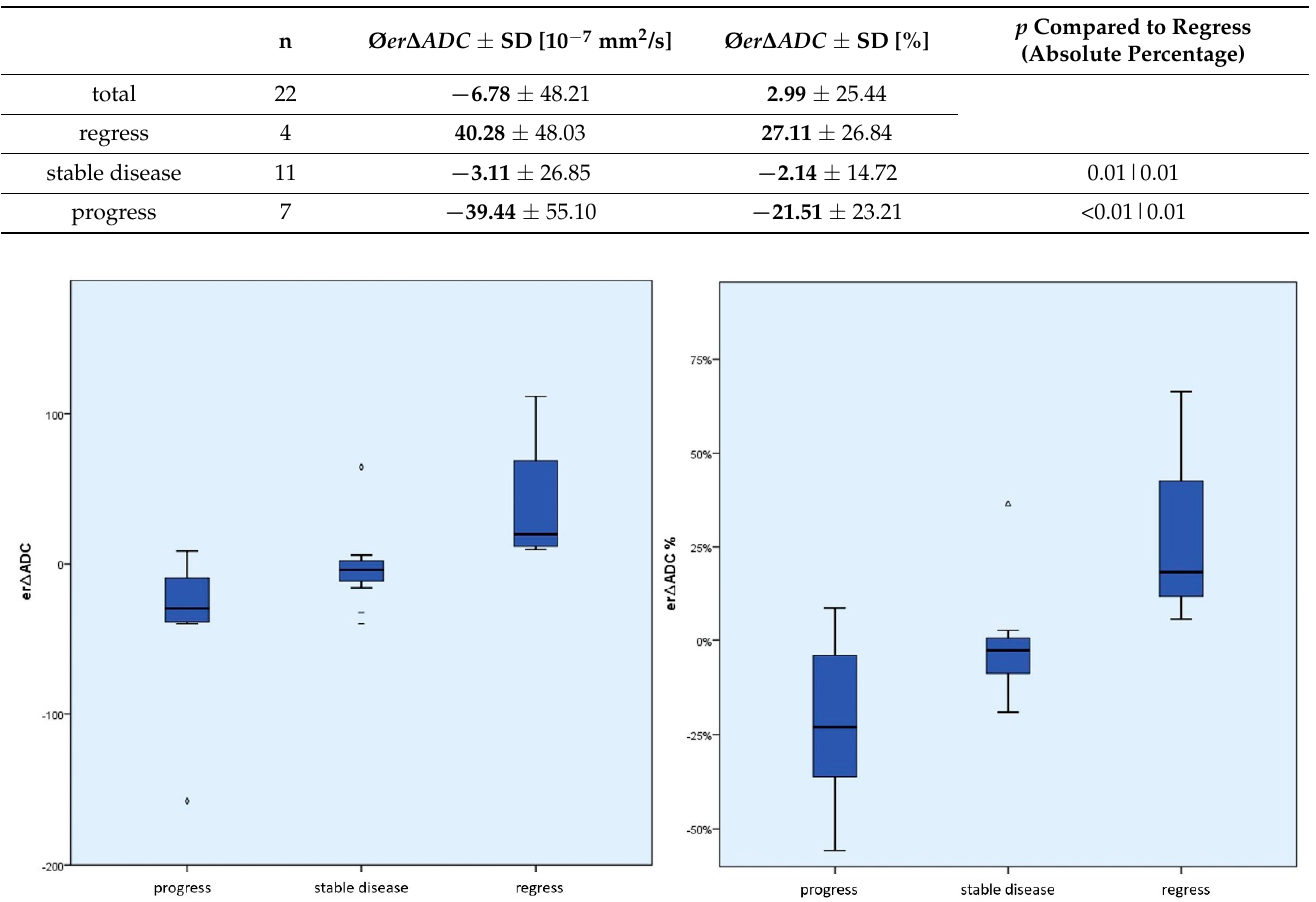
Figure 6. Box plot of the absolute or percentage er ∆ ADC values according to the course of the disease (outliers, min./max. in whiskers or individually). This shows an absolute and relative ADC increase in tumor regression compared to stable disease and tumor progression or an absolute and relative ADC decrease in tumor progression compared to stable disease and tumor regression. In particular, there were no negative er ∆ ADC values in the case of tumor regression. (dashes = mild outliers; triangles = extreme outliers).